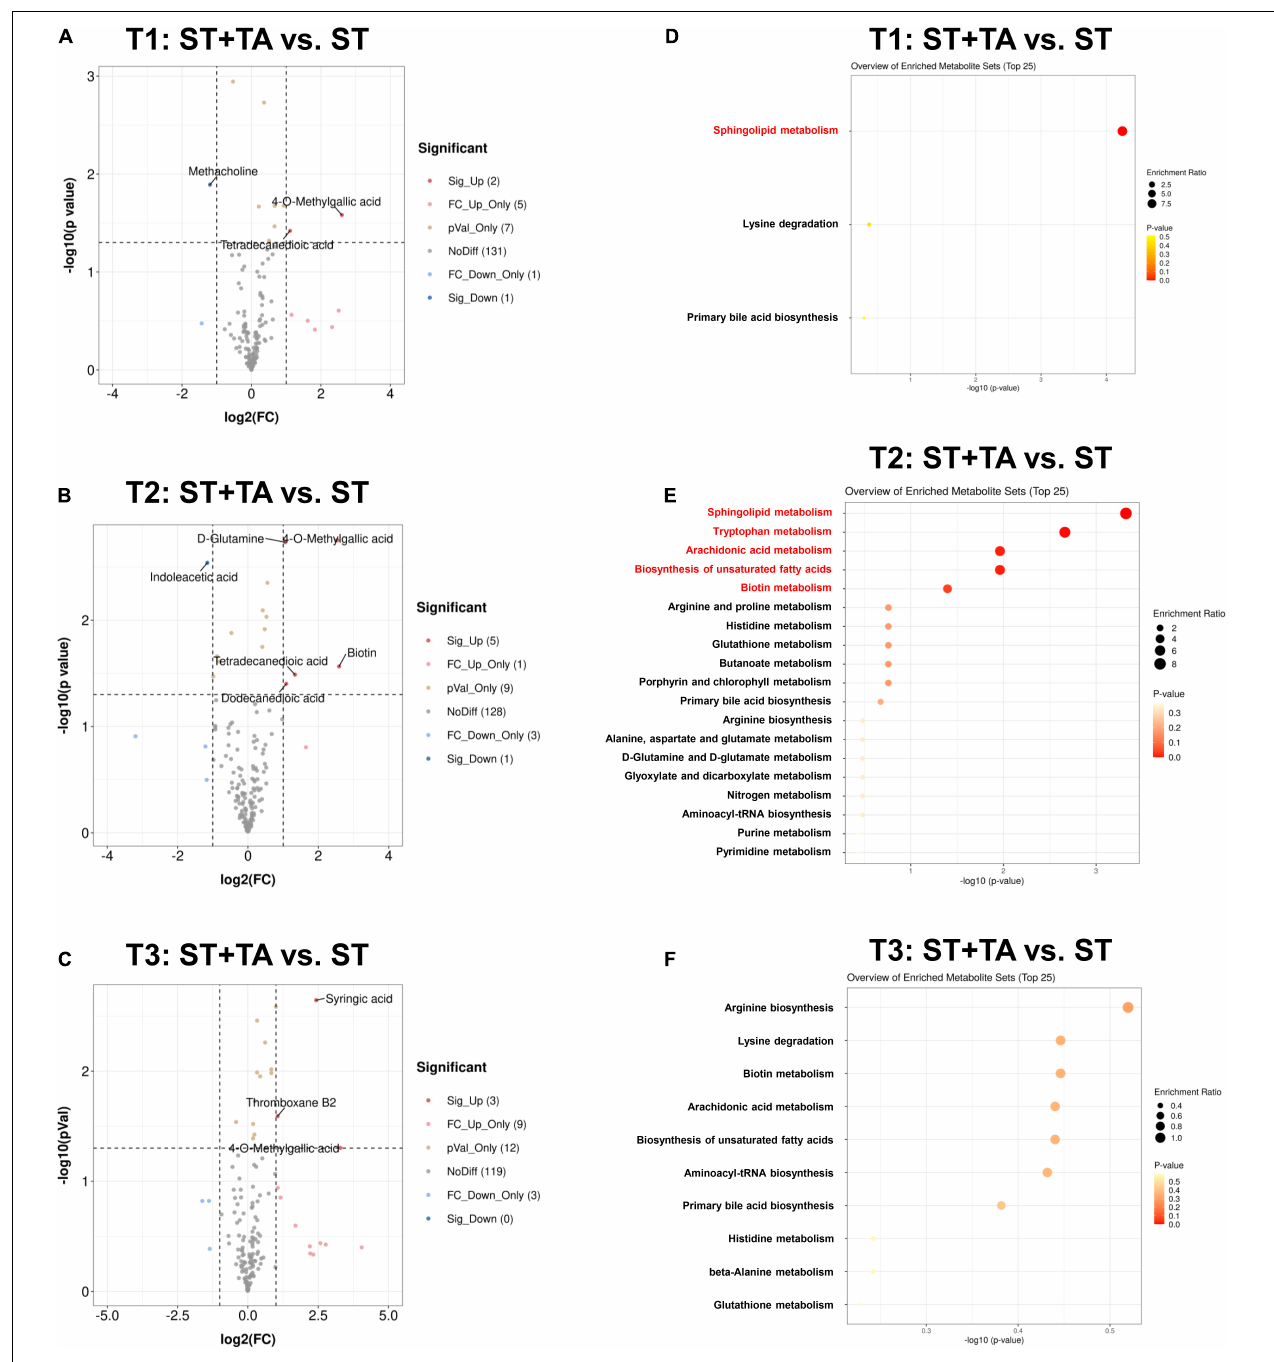
FIGURE 7 | Effect of TA on serum metabolome in dogs. Volcano plot (A–C) and enrichment analysis of metabolic pathways (D–F) . The red font indicates significantly different metabolic pathways ( p < 0.05). T1, day 7 before transportation; T2, day 8 after transportation; T3, day 14 after transportation.